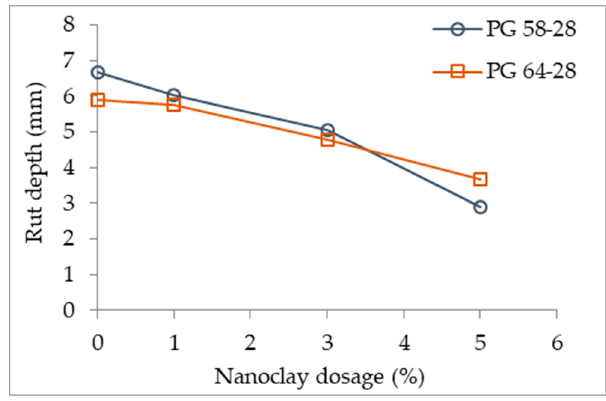
Figure 7. E ff ect of nanoclay dosage on rut depth [94]. Figure 7. Effect of nanoclay dosage on rut depth [94].